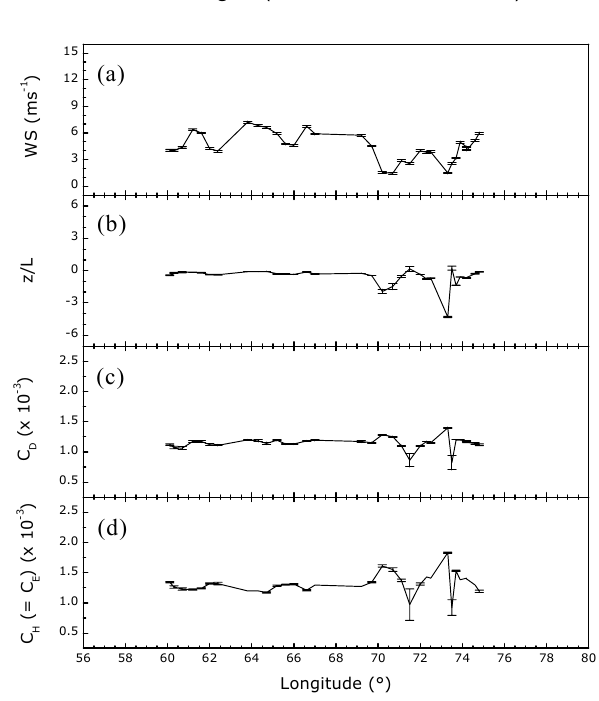
Fig. 6. Same as Fig. 4, but for cruise leg-4.